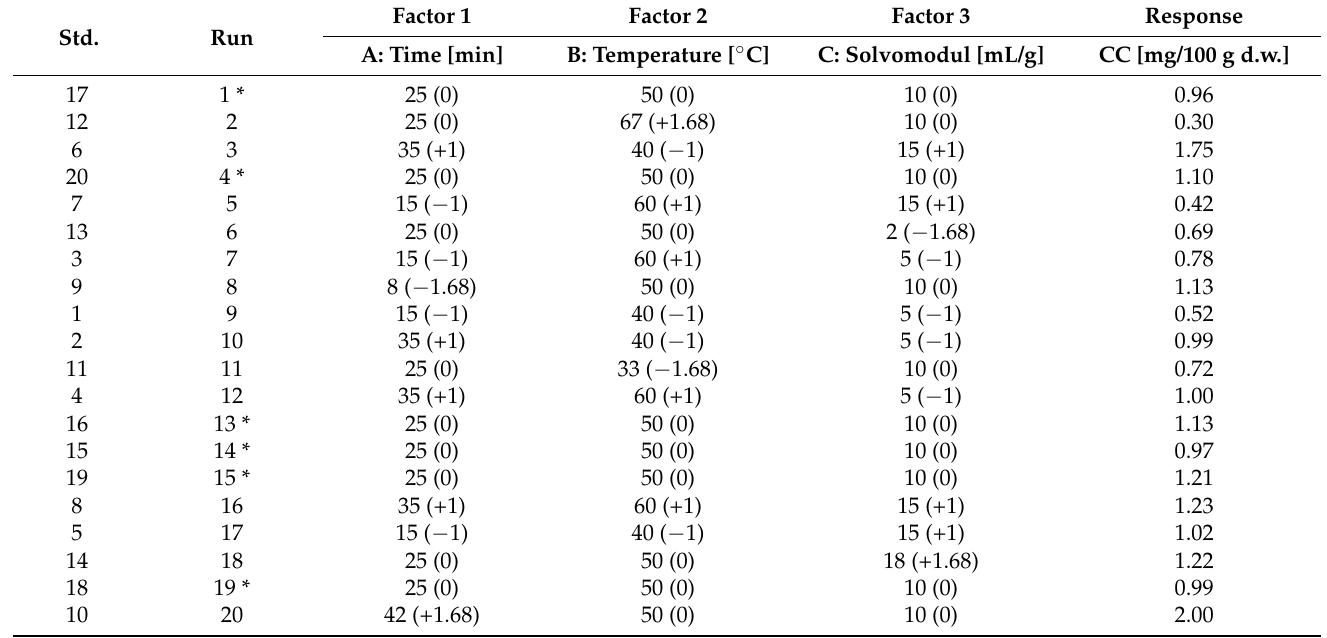
Table 3. Matrix of CCD with three